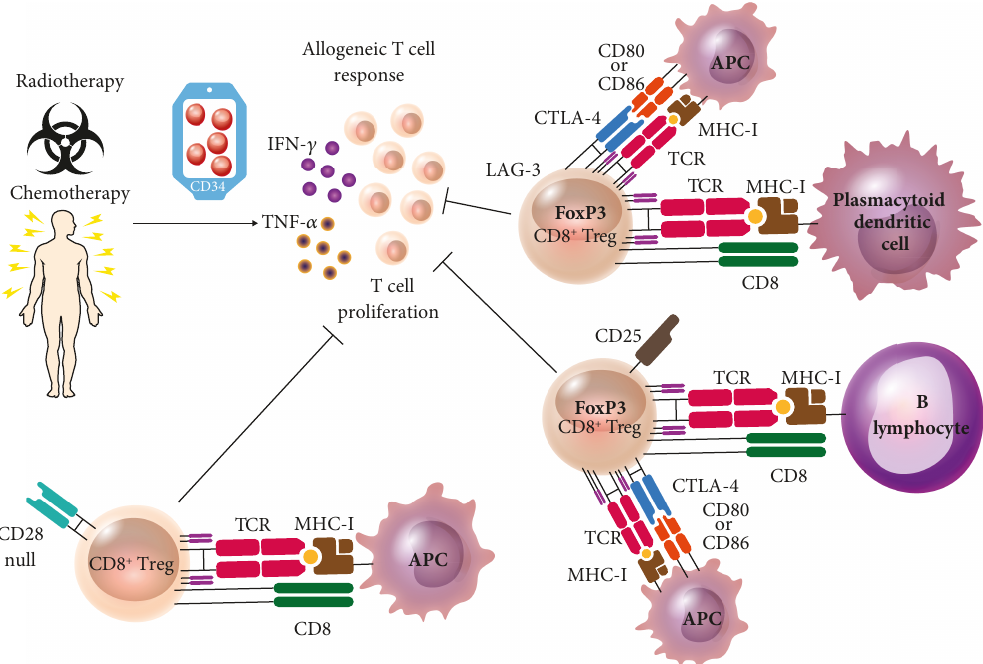
Figure 5: Participation of CD8 + Treg lymphocytes in GVHD. After the remission of an oncohematologic disease, patients are treated with chemotherapy and radiotherapy. Later, they receive a hematopoietic stem cell graft from an HLA-compatible donor, at risk of developing GVHD that is characterized by being proin fl ammatory and producing IFN- γ and TNF- α . This response can be stopped by CD8 + Treg lymphocytes. When they encounter a plasmacytoid dendritic cell, lymphocytes are activated; they acquire phenotype LAG- 3 + FoxP3 + CTLA-4 + and are able to suppress T lymphocyte allogeneic response via CTLA-4. If they are activated by a B lymphocyte, the CD8 + Tregs will express CD25 + CTLA-4 + FoxP3 + , which suppresses cell proliferation and release of proin fl ammatory cytokines. The CD8 + CD28 − , a regulatory T cell subpopulation, play a critical role in in vitro and in posttransplantation allogeneic response. They can be generated by in vitro interaction with allogeneic peripheral blood mononuclear cells. Epitope presented in MHC-I is an alopeptide (allogeneic peptide) in all three Treg